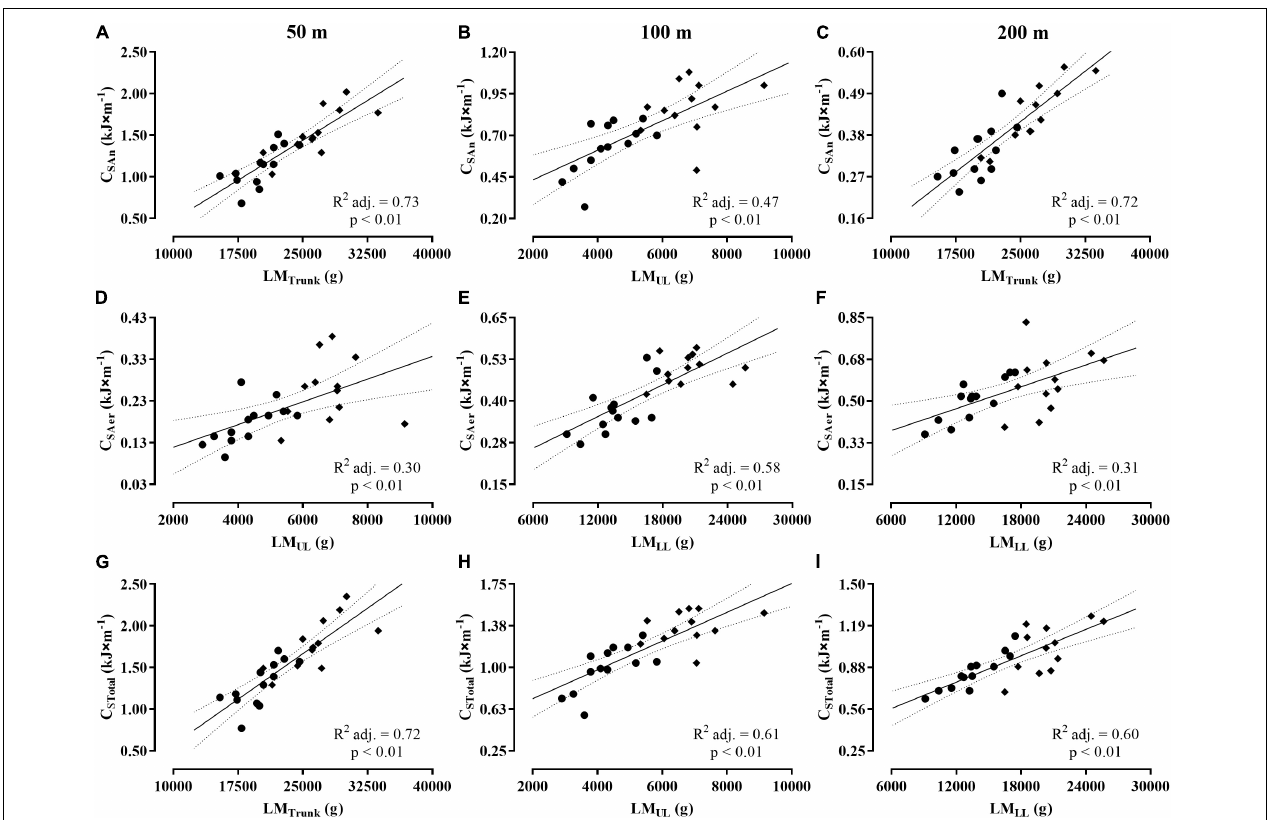
FIGURE 5 | Dispersion plots between body composition variables and values of C An , C Aer , and C Total for the 50 m (A,D,G) , 100 m (B,E,H) , and 200 m (C,F,I) . Obs.: The symbols ( (cid:7) ) and ( ) represent the dispersion for men and women, respectively. The acronyms CAn, CAer, and CTotal represent the anaerobic, aerobic, and total (cid:32)